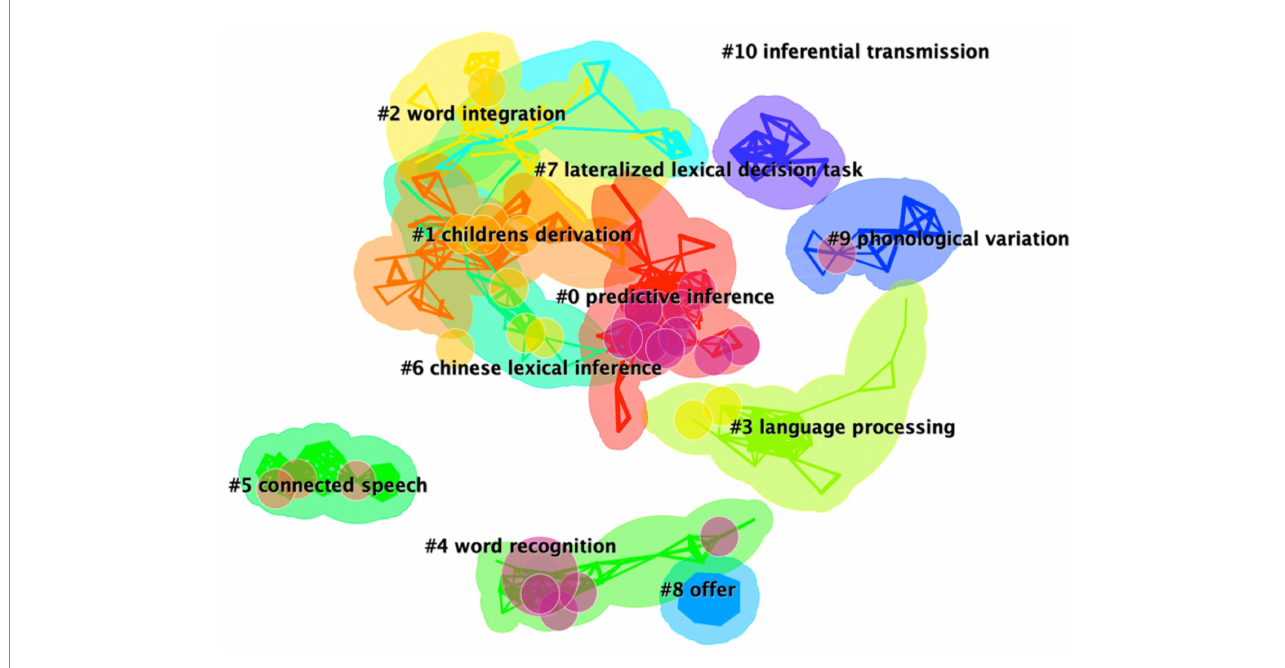
FIGURE 4 Network map of major clusters of lexical inferencing between 2001 and 2021.